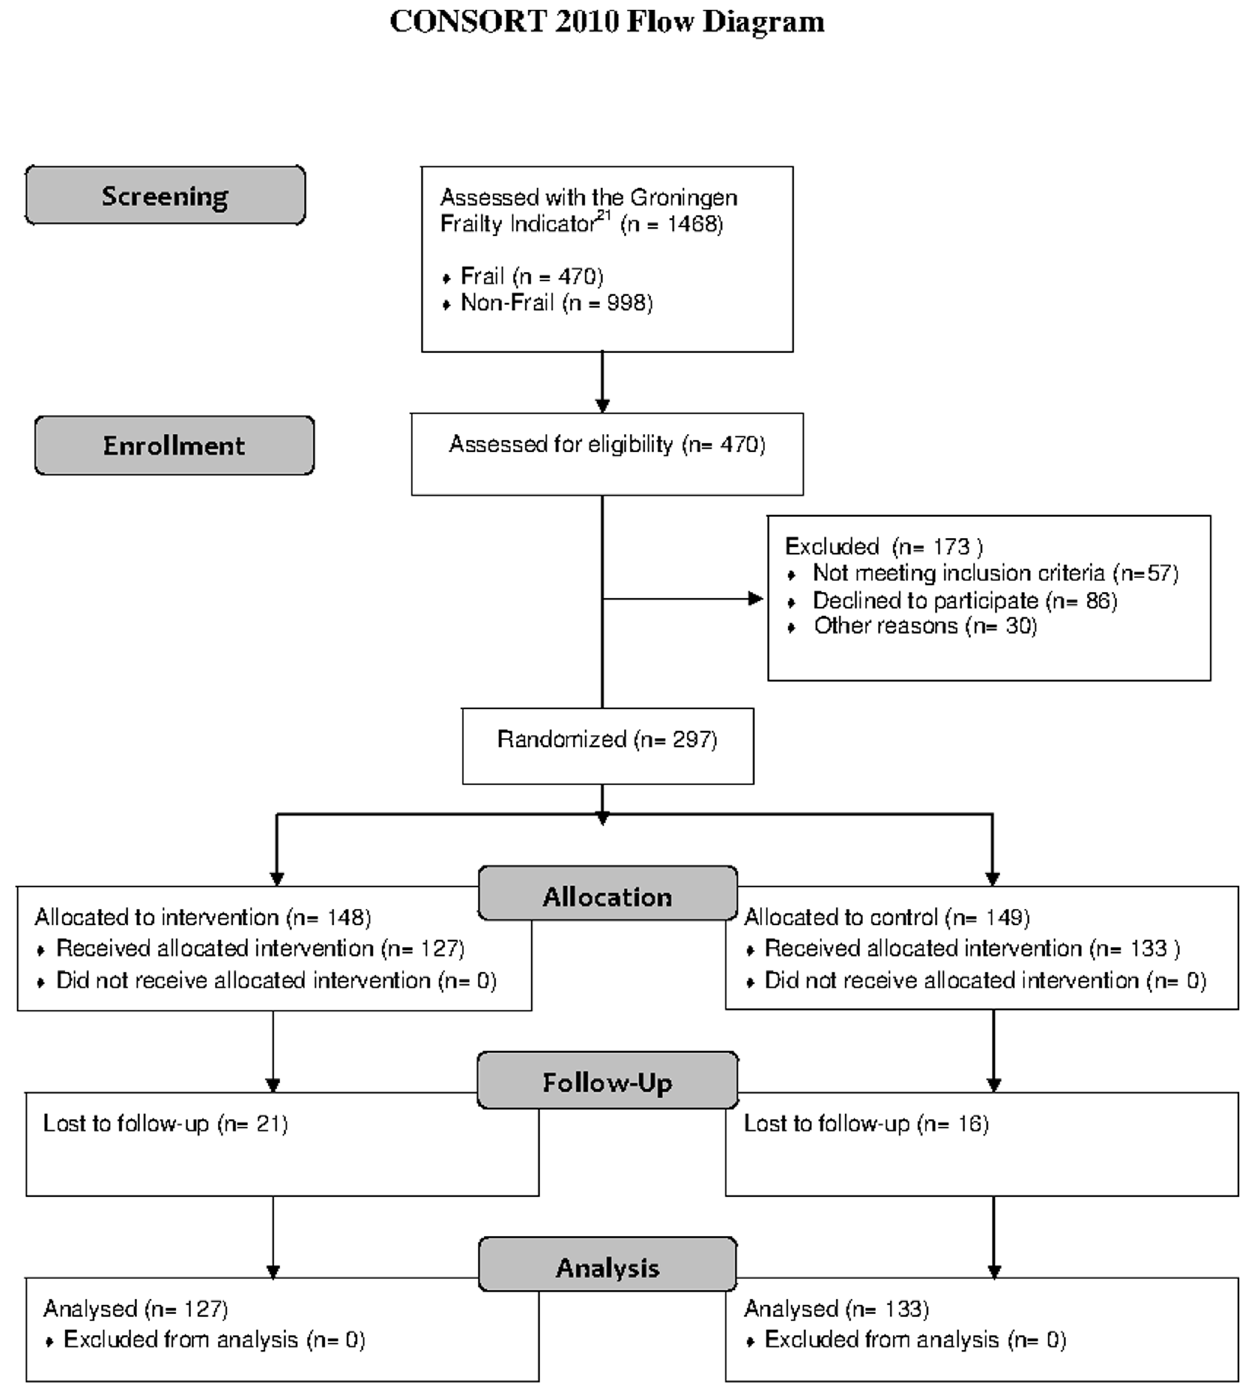
Figure 1. CONSORT diagram for the study.